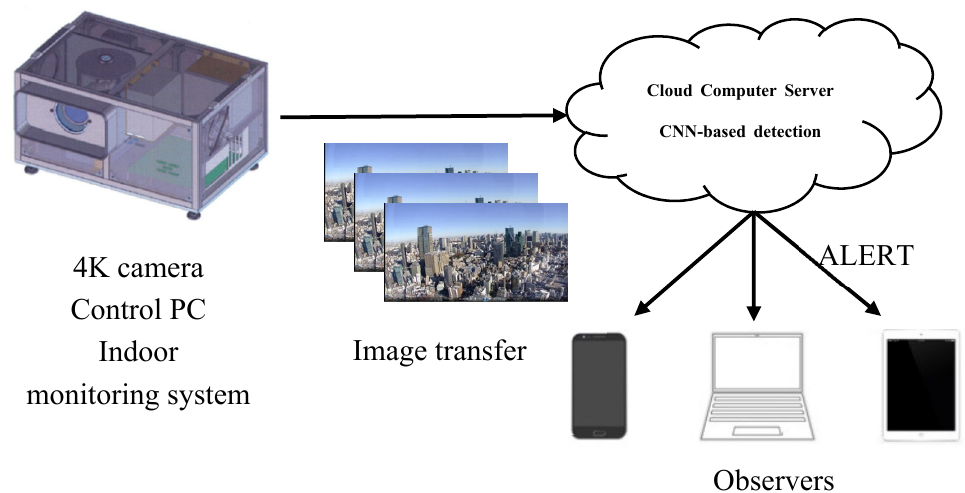
Figure 1. Proposed system configuration.